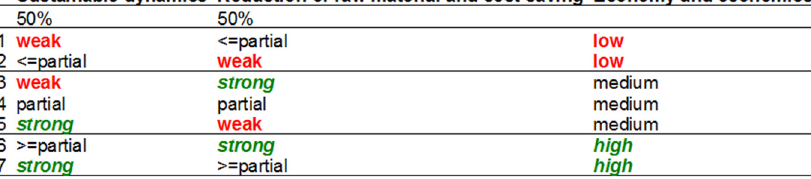
Figure A3. Utility function of the aggregated attribute Economy and economics.